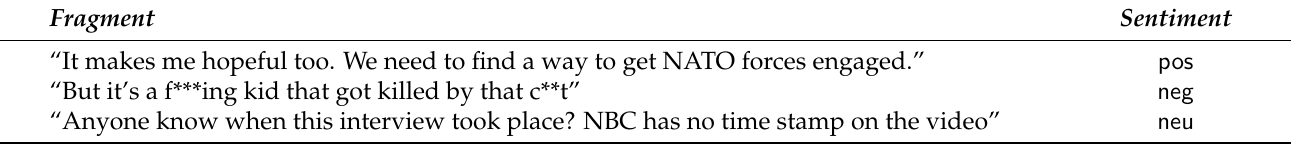
Table 4. Some examples of fragments and their sentiments derived by roBERTa-base (swear words are partially